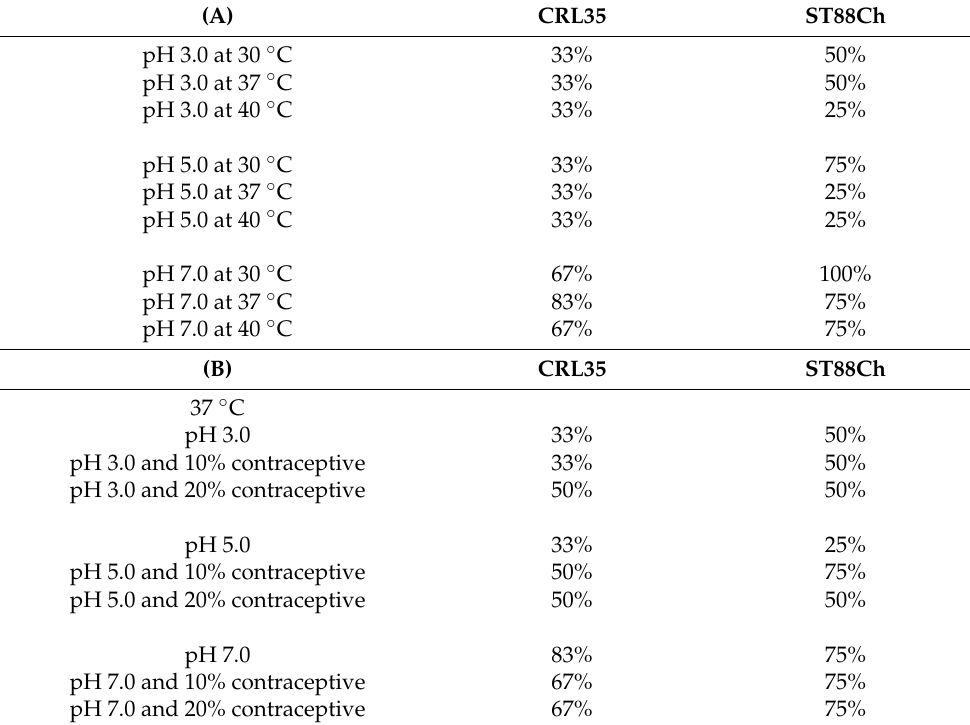
Table 3. Evaluation of the adsorption of BLIS produced by E. mundtii CRL35 and E. faecium ST88Ch to C. albicans 1281 at pH 3.0, 5.0 and 7.0 and 30 °C, 37 °C and 40 °C (A), and in presence of 10% and 20% Nordette ‐ 28 (B). The presented results are representative of the three repetitions of the men ‐ tioned experiments.